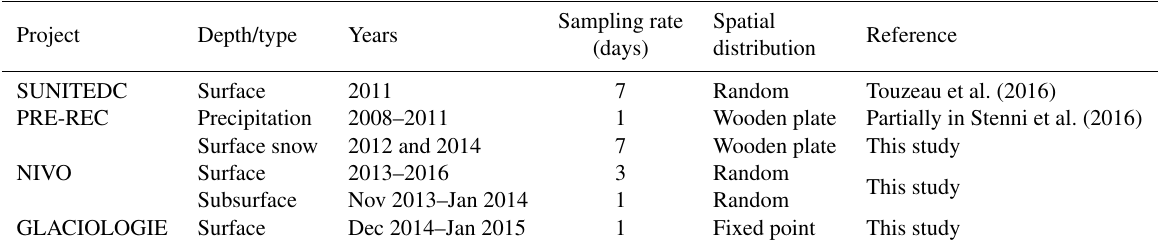
Table 2. Summary of the different surface snow and precipitation samplings. Precipitation samples were collected at 01:00 (UTC), when precipitation occurred. Surface snow refers to the top 5 to 30mm of the firn, and subsurface snow refers to depths between 30 and 60mm. Project